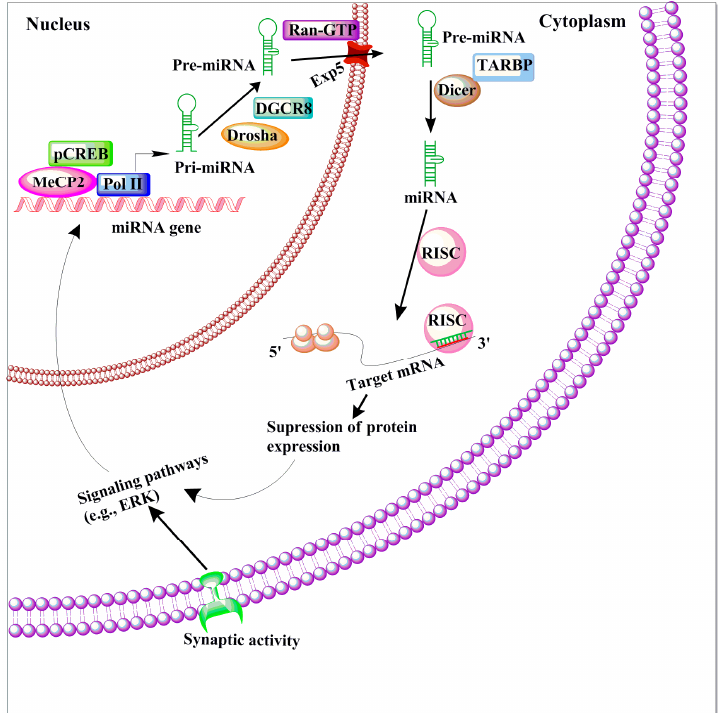
Figure 4. The schematic diagram of miRNA biogenesis and function. In the nucleus, RNA polymerase II (Pol II)-dependent transcription of a miRNA-encoding gene, which may include both intron- and exon-coding regions, results in the formation of a long primary miRNA transcript (pri-miRNA) that is 50-capped and 30-polyadenylated. This pri-miRNA transcript is subject to nuclear processing by the microprocessor complex, which includes DCGR8 and Drosha, into the precursor miRNA (pre-miRNA) transcript. Pre-miRNAs are transported out of the nucleus to the cytoplasm by Exp5 and Ran-GTP. Pre-miRNA can then be further cleaved by Dicer/TARBP to generate a mature miRNA. The mature miRNA is incorporated into the RNA-induced silencing complex (RISC), which will select mRNA transcripts for the down-regulation of protein expression. In the synapses, miRNA can regulate the local down-regulation of protein expression. Certain conditions, such as neuronal activity, could affect the signaling events as well as miRNA formation. Additionally, genes regulated by miRNA can act on synaptic activity-dependent signaling pathways that promote the activation of epigenetic factors (e.g., CREB and MeCP2), which in turn can control miRNA transcription in the nucleus.